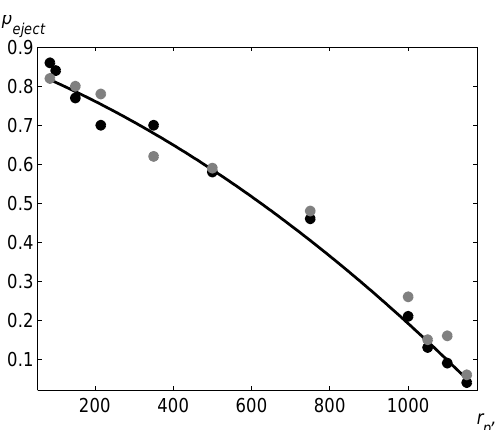
Fig. 1. Probabilities of HVS ejection computed for MR Cyg versus the pericenter distance, for a fixed position of the apocenter (black circles are for r a = 10 4 R ⊙ and grey circles for 10 5 R ⊙